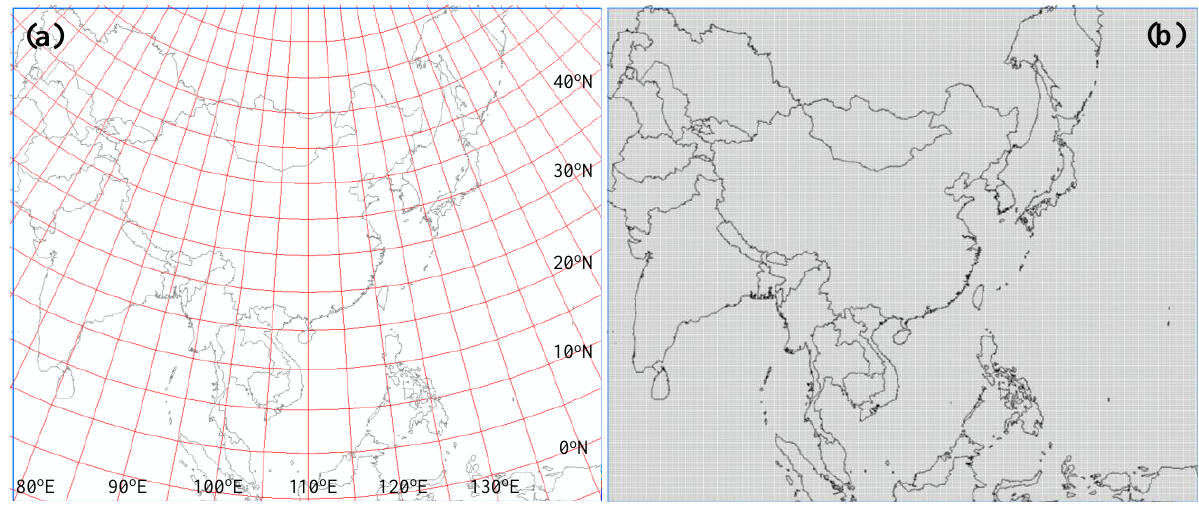
Figure 1. Asia RCM domain overlaid with (a) latitude and longitude and (b) the 301 × 251 dimensional 30-km spacing